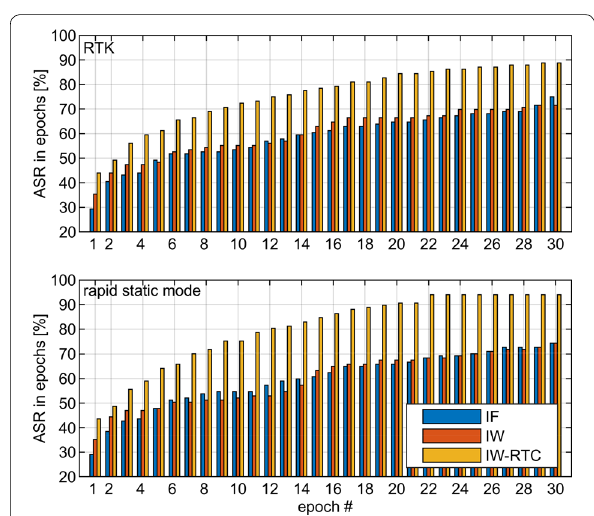
Fig. 9 Ambiguity success rates as a function of sessions’ length obtained in a cumulative RTK and rapid static mode solutions during high ionospheric